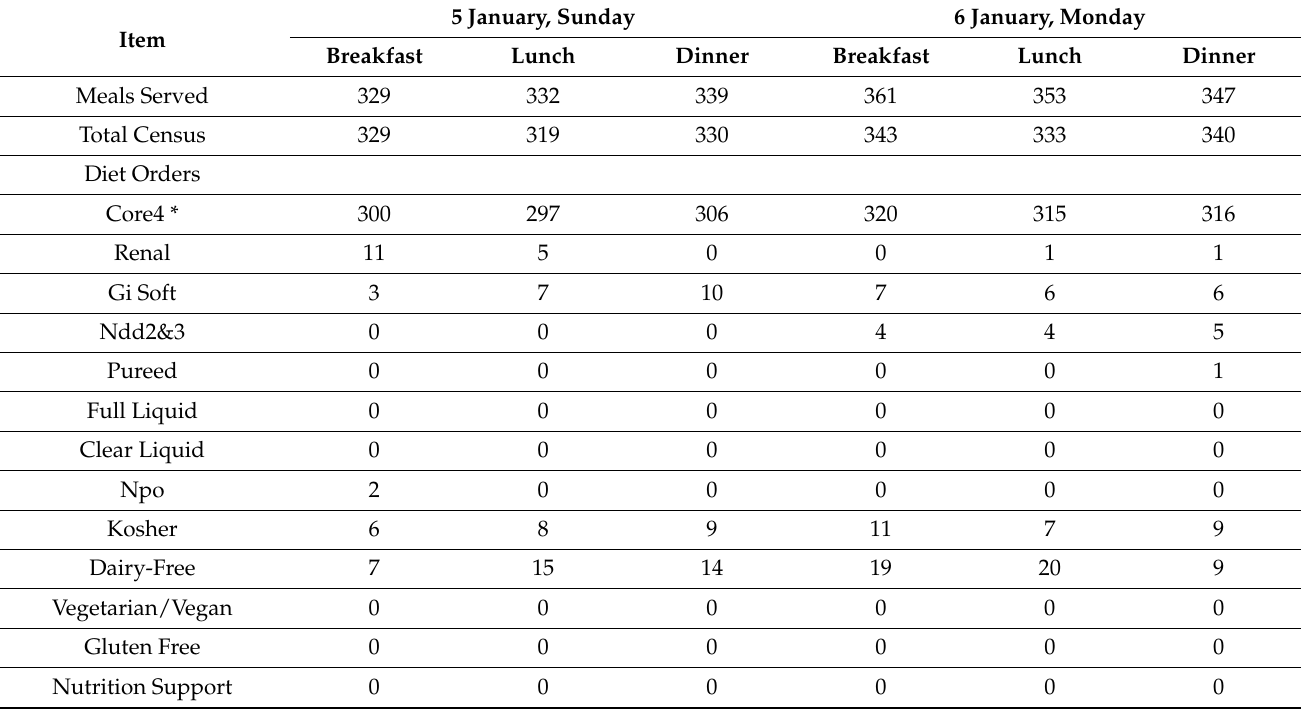
Table 3. An example of the ‘Patient Census and Diet Order Tracker,’ designed to facilitate meal forecasting in a disaster response setting. This is done by recording the number of patients consuming different types of meals over pre-determined mealtimes in a field hospital. Within an hour of meal delivery, the tracker was cross-verified with ‘Diet Rosters’ and updated to communicate pre-service meal requirements to food contract staff. During meal delivery, the tracker was routinely updated as 68Ms completed their meal deliveries and/or as patients were admitted or discharged from JNYMS. Lastly, within 30 min of final meal delivery, the tracker was updated to reflect total meal served. Daily and weekly tallies of delivered meals were used to estimate the popularity of food supplies in the patient population. This tracker also served as a quality control tool in which the total number of meals delivered per meal period were matched to the current patient census, and this ensured every patient received a